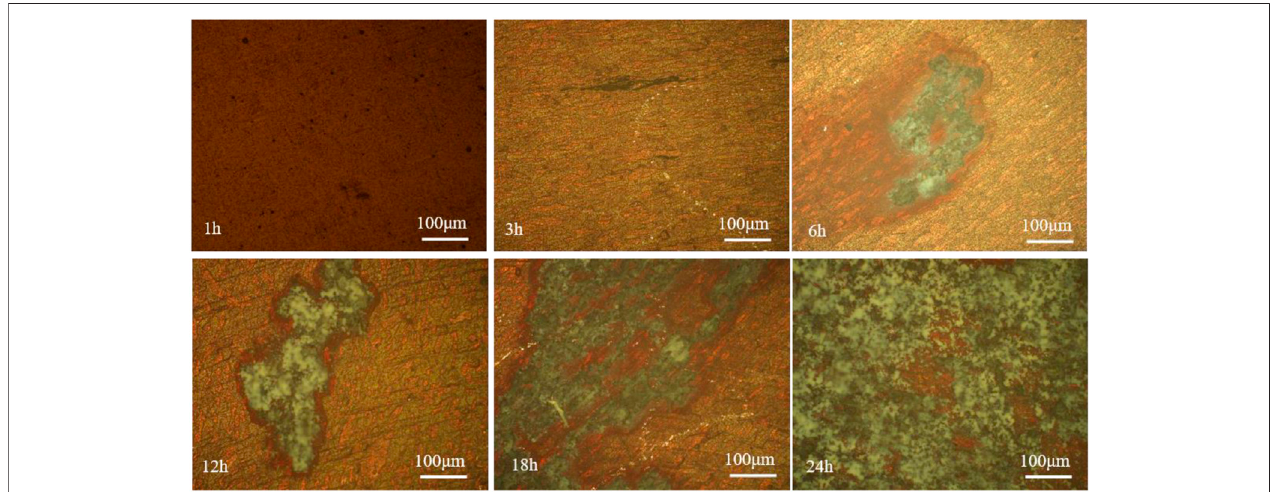
FIGURE 2 | Surface morphologies of the specimens in 3.5% NaCl solution.